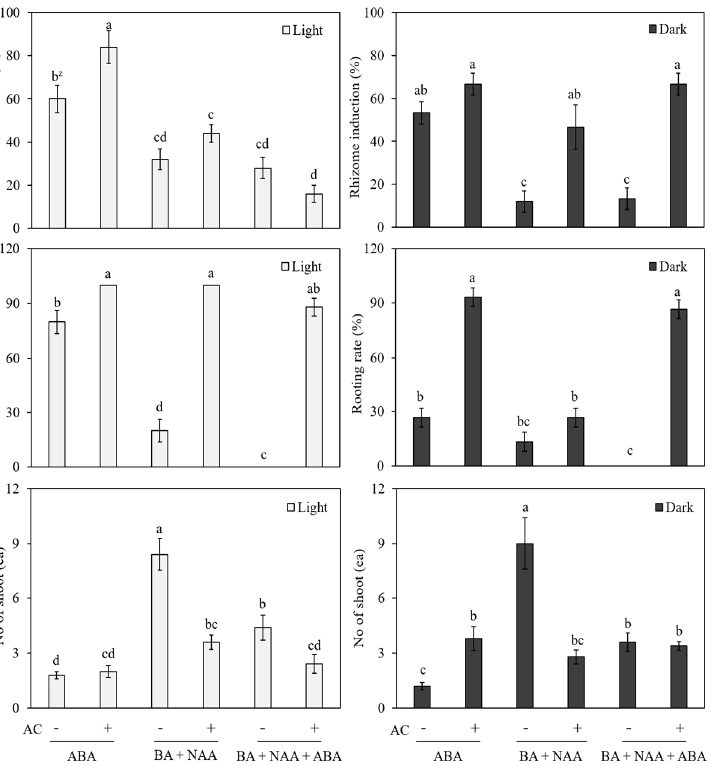
Figure 6. Effect of ABA, BA, and NAA with or without activated charcoal (AC) and under light or dark conditions on rhizome induction of Cnidium officinale . Different letters in each bar significantly differ from each as per DMRT ( p < 0.05).